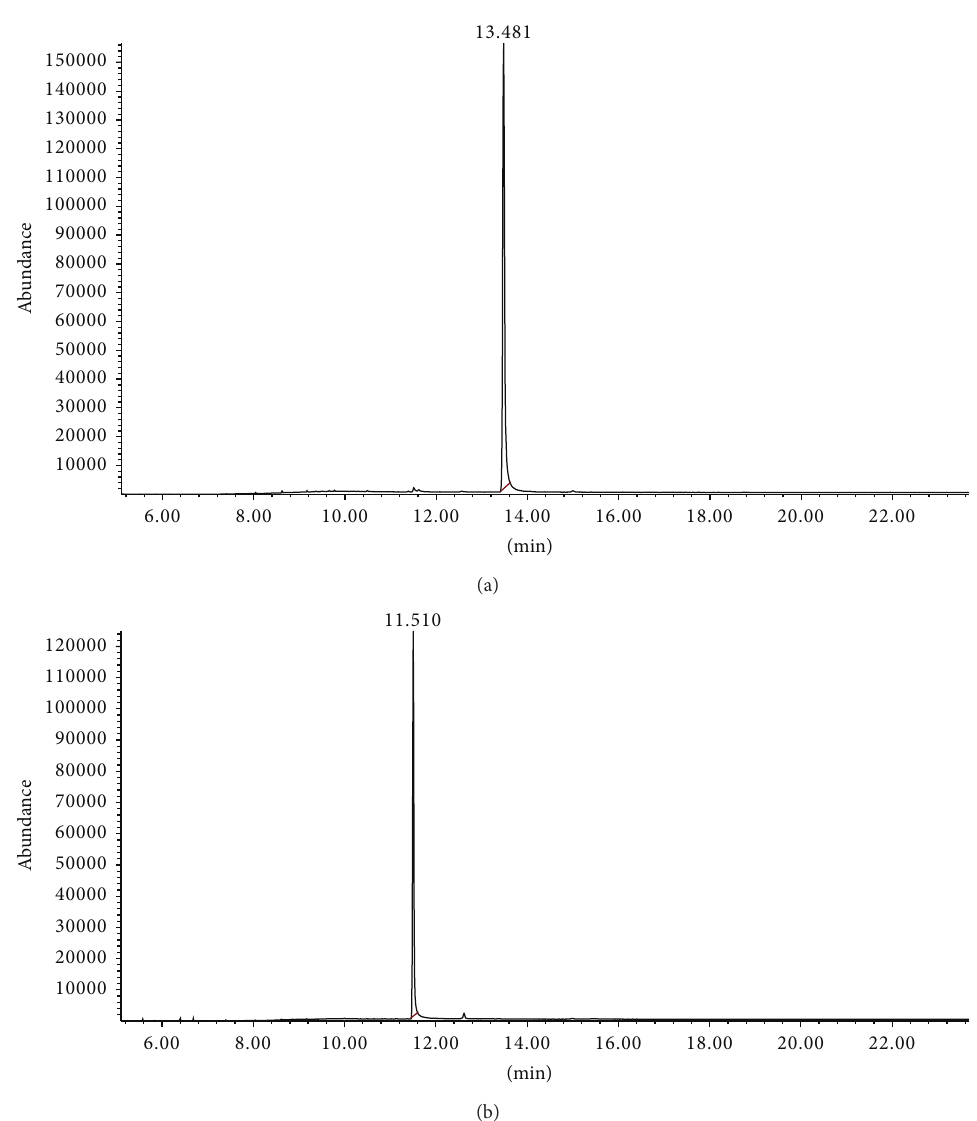
Figure 2: Chromatograph of urine sample containing 1600 ng/mL morphine (a) and codeine (b) processed through the procedure.